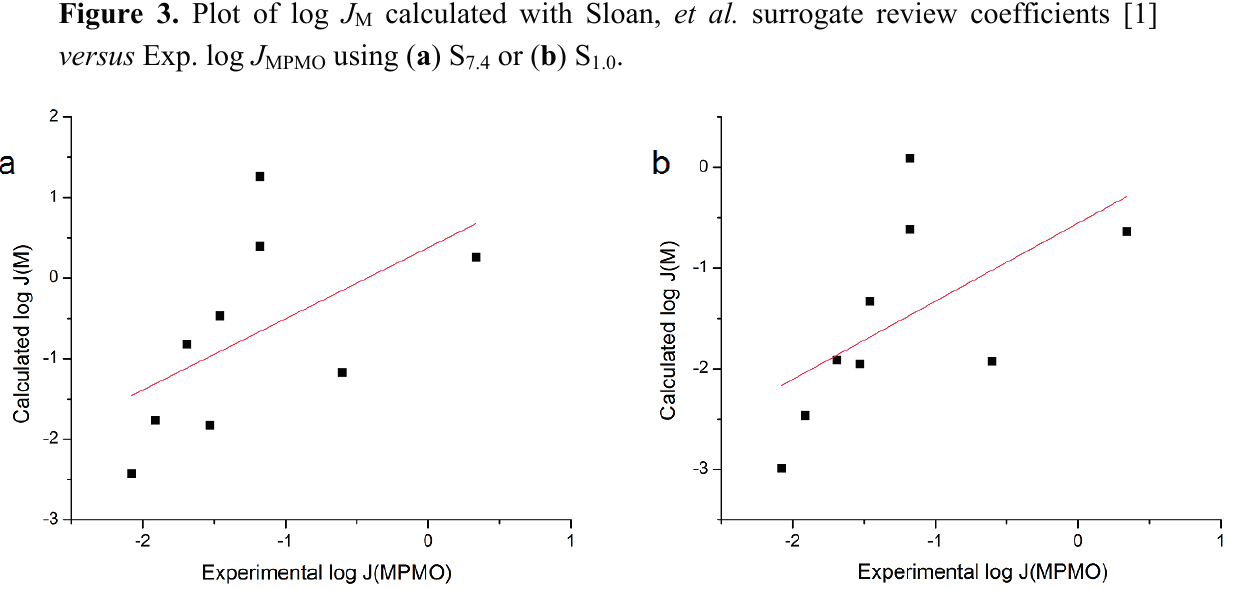
Figure 3. Plot of log J versus Exp. log J